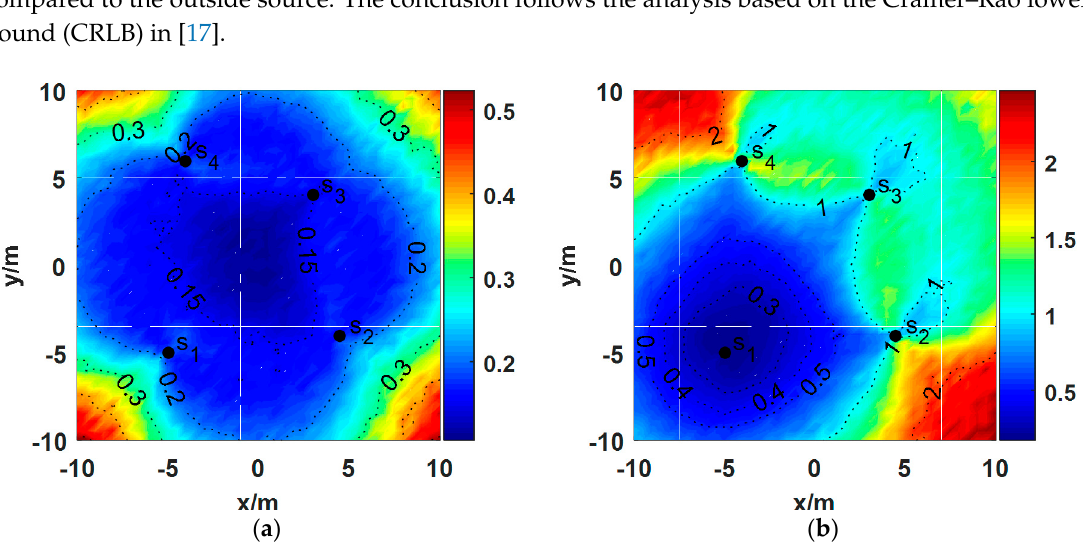
Figure 2. Root-mean-square error (RMSE) for different source positions when four nodes are deployed in a 20 × 20 m 2 test area: ( a ) σ 1 = σ 2 = σ 3 = σ 4 = 1 ◦ ; ( b ) σ 1 = 10 ◦ , σ 2 = σ 3 = σ 4 = 1 ◦ . The black dots denote the nodes, and the numbers on the dotted line contours are the values of the RMSEs.